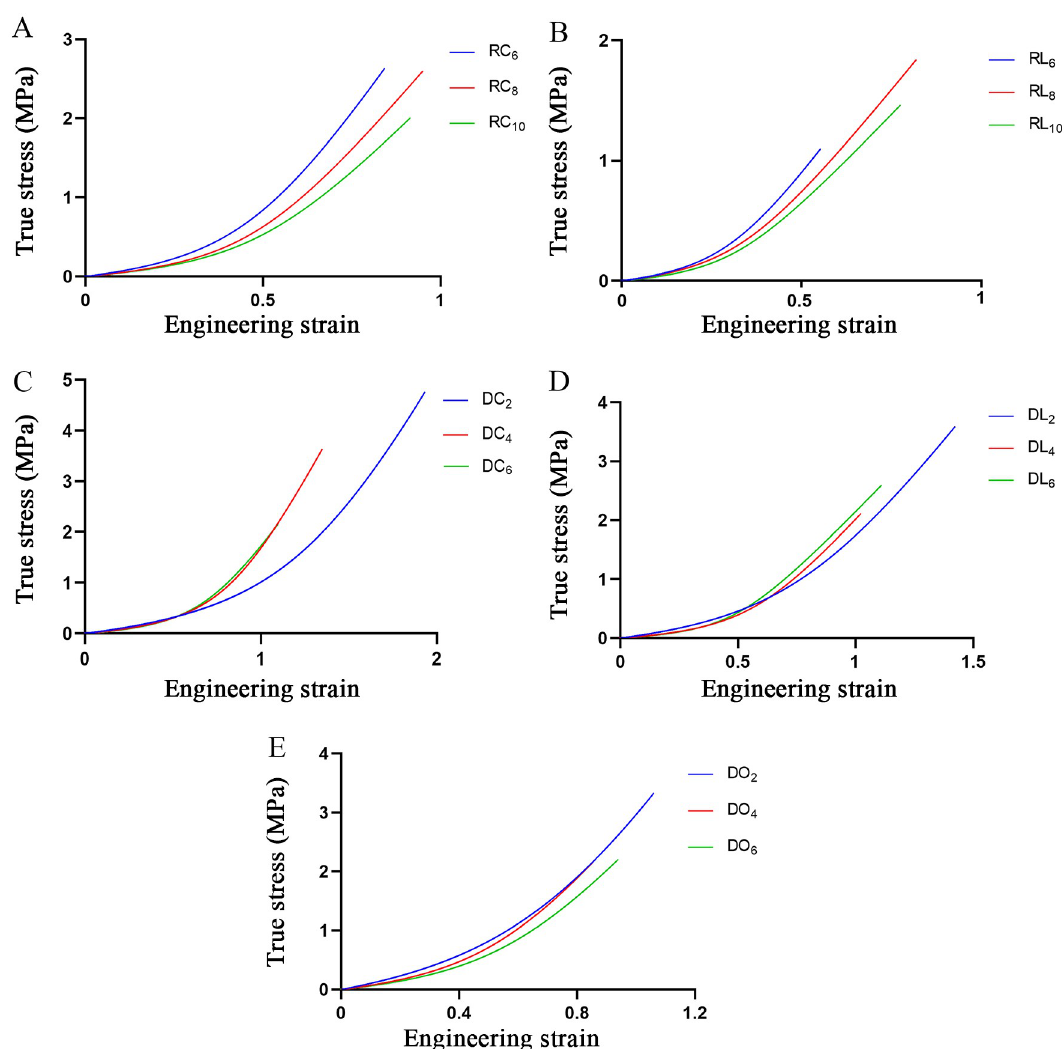
axial specimens. (E) The groups of dog-bone-shaped oblique